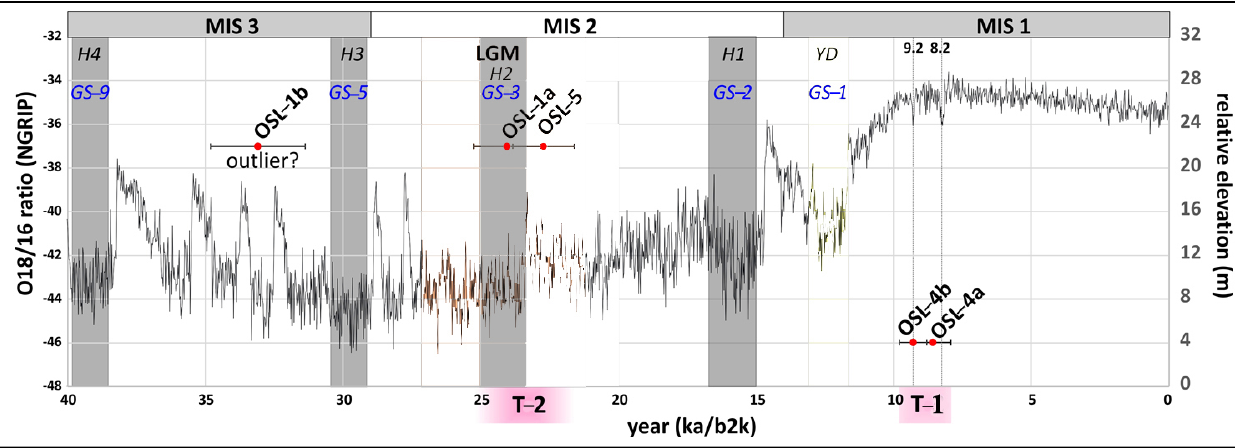
Figure 8. Correlation of OSL ages from two steps in the terrace staircase of the Muş Basin with NGRIP ice core d18O data (NGRIP Members, 2014), (MIS boundaries from Lisiecki and Raymo, 2005) and (Heinrich events and Greenland Stadials, according to Rasmussen et al., 2014). T2 has been deposited during the LGM and coincides with the H2 cold period. T3 marks the end of the early Holocene.